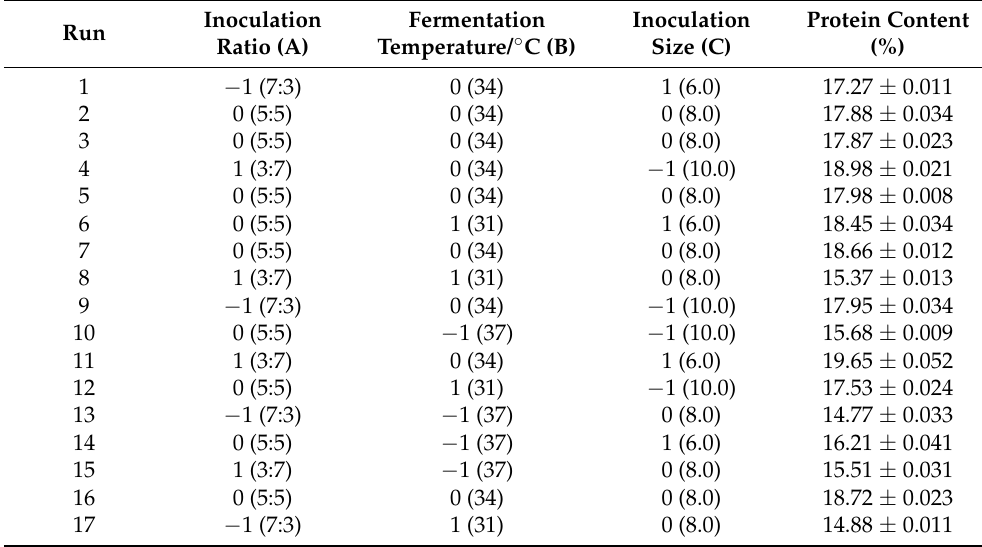
Table 9. The design and results of the response surface methodology for the second stage of the SSF.